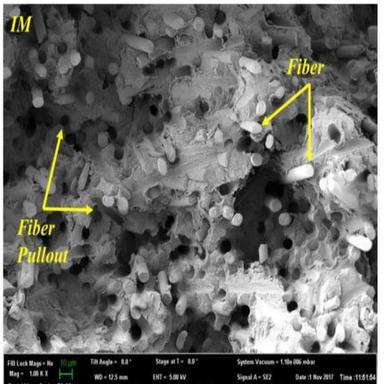
SEM micrographs of a fracture surface of tensile samples; (a) EDF-AM: Most of the fibers are aligned in printing direction, also contain voids; (b) ECM: Fibers are well distributed in all directions and (c) IM: Fibers are well aligned in flow directions. All samples showed fiber pullout.